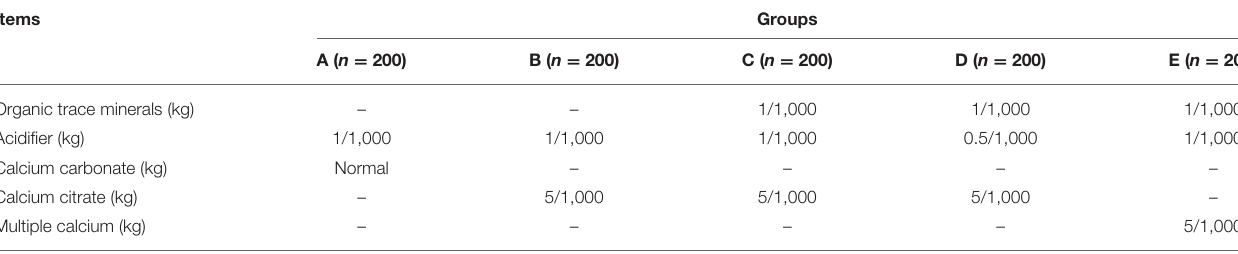
TABLE 1 | Experimental diets for 1,000 weaned piglets.